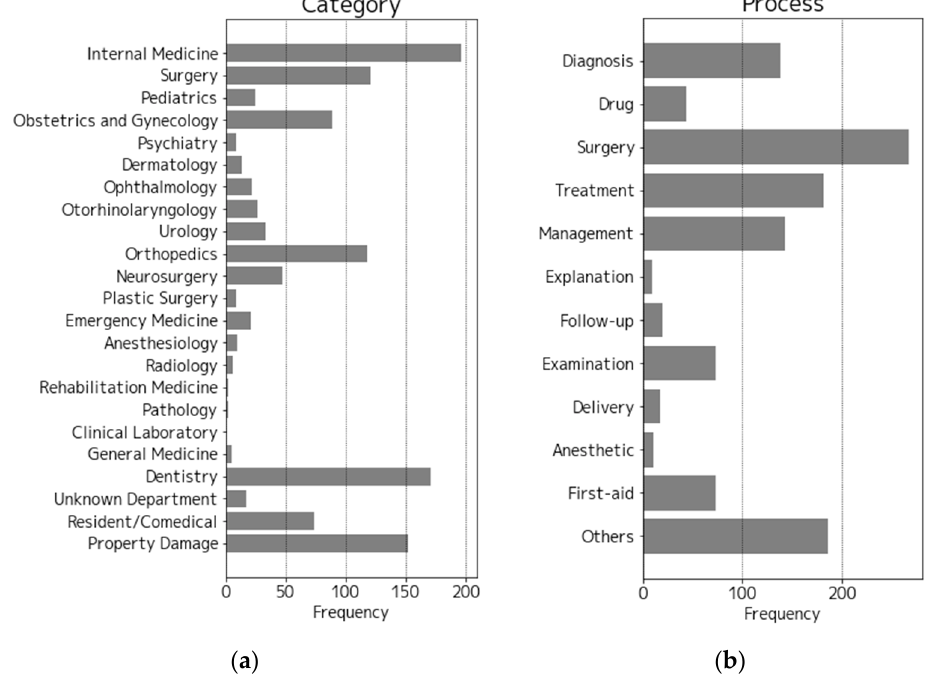
Figure 3. The ( a ) categories and ( b ) processes that occurred most often in the dataset according to their frequency of appearance.